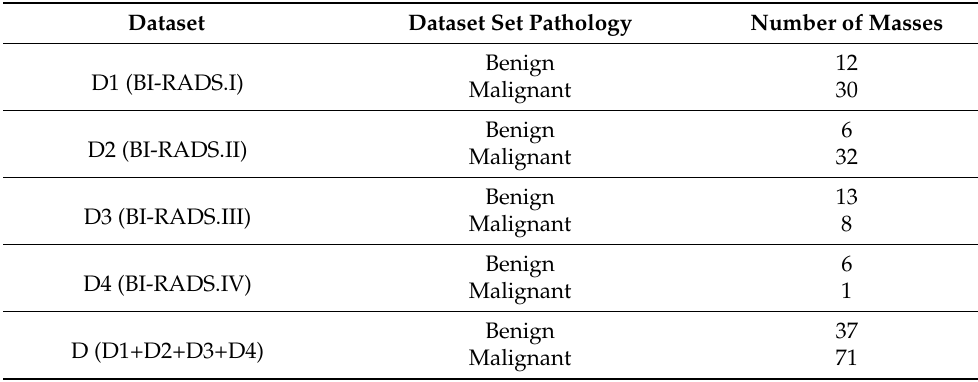
Table 3. Number of INbreast mass ROI